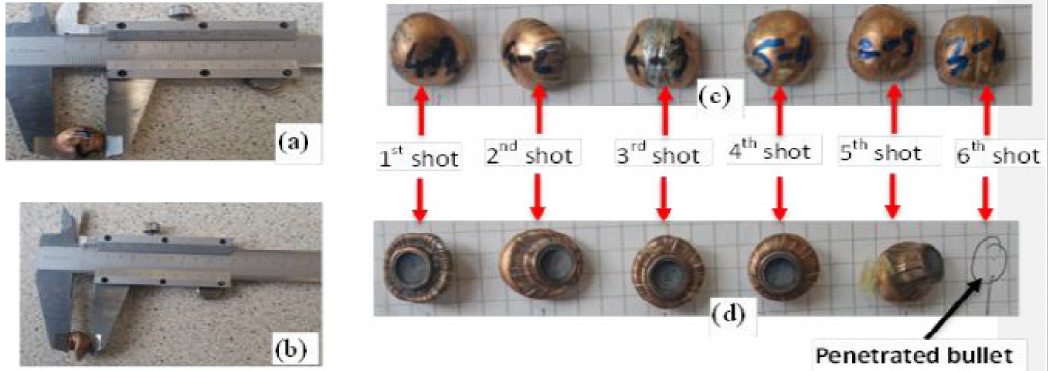
Figure 9. Recovered projectile debris diameter and length measurements ( a , b ) measurement system ( c , d ). Images of the recovered projectile debris after armour panel test.